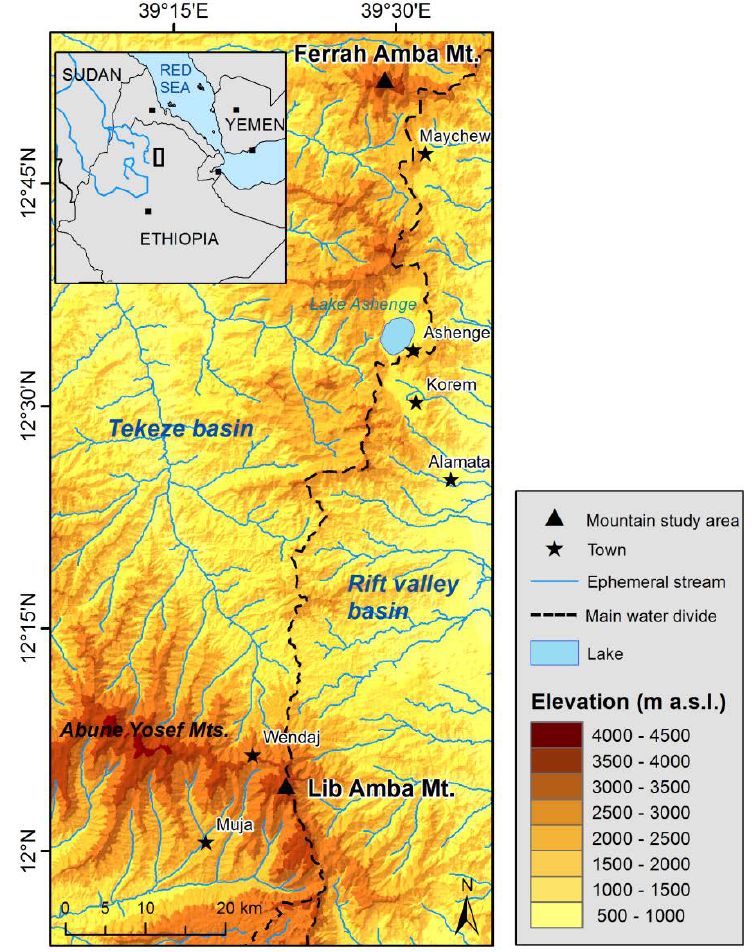
Figure 1. Location of the study area.